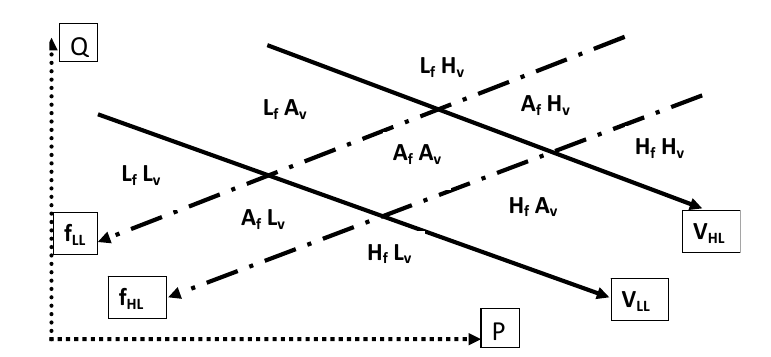
Figure 13. Sub-regions operating area.